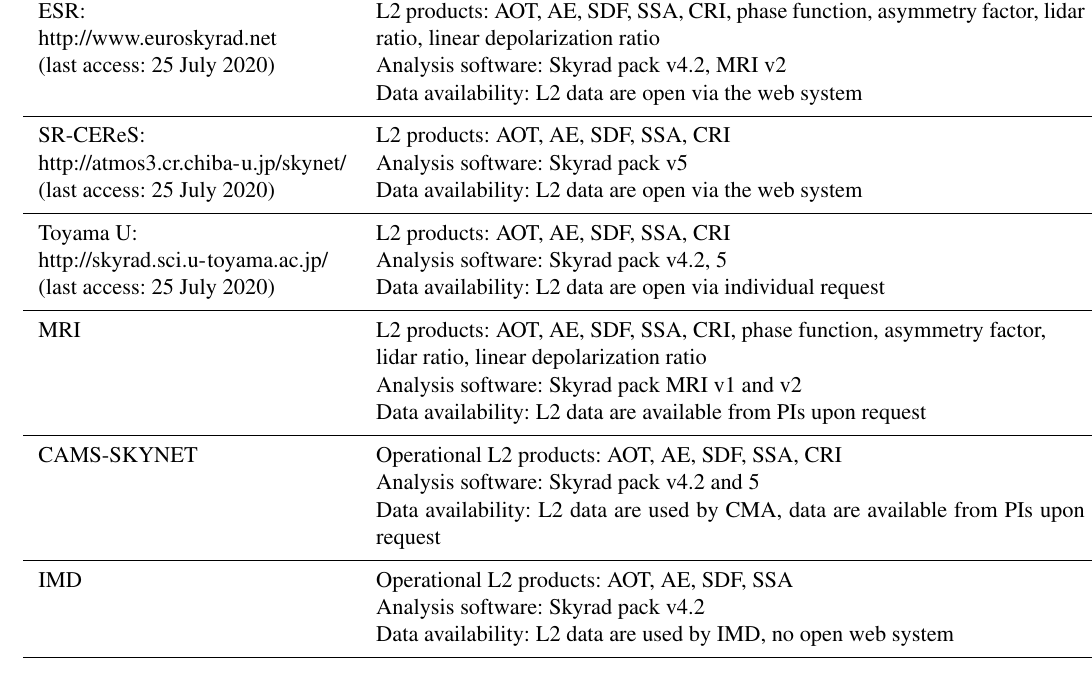
Table 2. Geophysical parameter products, versions of Skyrad pack, and availability of the known data archives. ESR: L2 products: AOT, AE, SDF, SSA, CRI, phase function, asymmetry factor, lidar